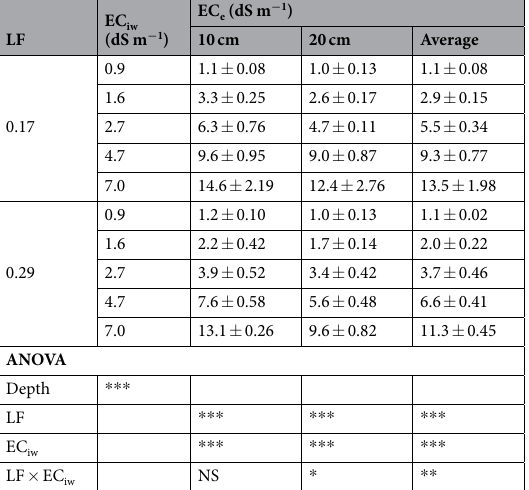
Table 1. Electrical conductivity of soil saturated paste extract (EC e ) in the 10 and 20 cm soil layers under various irrigation water salinity levels (EC iw ) and leaching fractions (LF) and output of the two–way analysis of variance (ANOVA) for EC e. * , ** and *** represent significant differences between means at 0.05, 0.01 and 0.001 level of probability, respectively; NS, non–significant. Each value is mean ± S.D. (n =